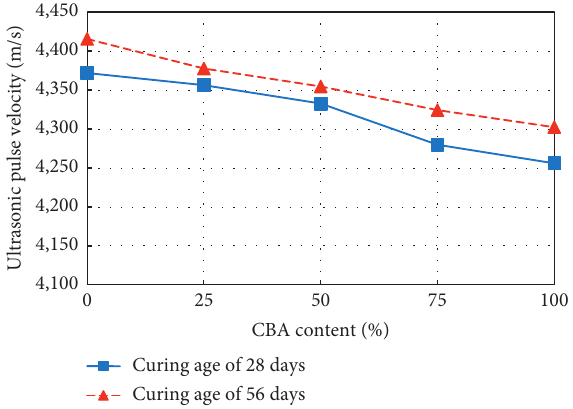
Figure 12: Ultrasonic pulse velocity test